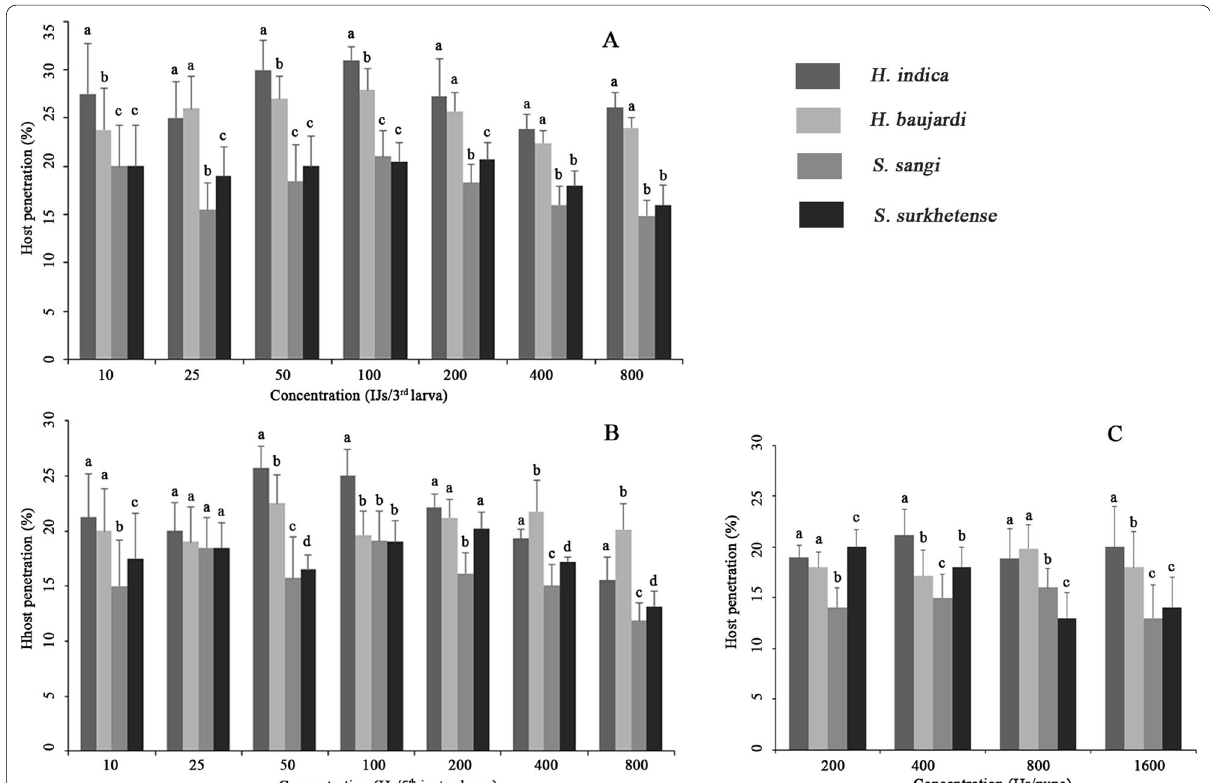
Fig. 5 Percentage penetration of the EPN isolates on A 3rd instar larvae, B 5th instar larvae and, C pupa of Spodoptera frugiperda upon exposure to different concentrations of nematodes